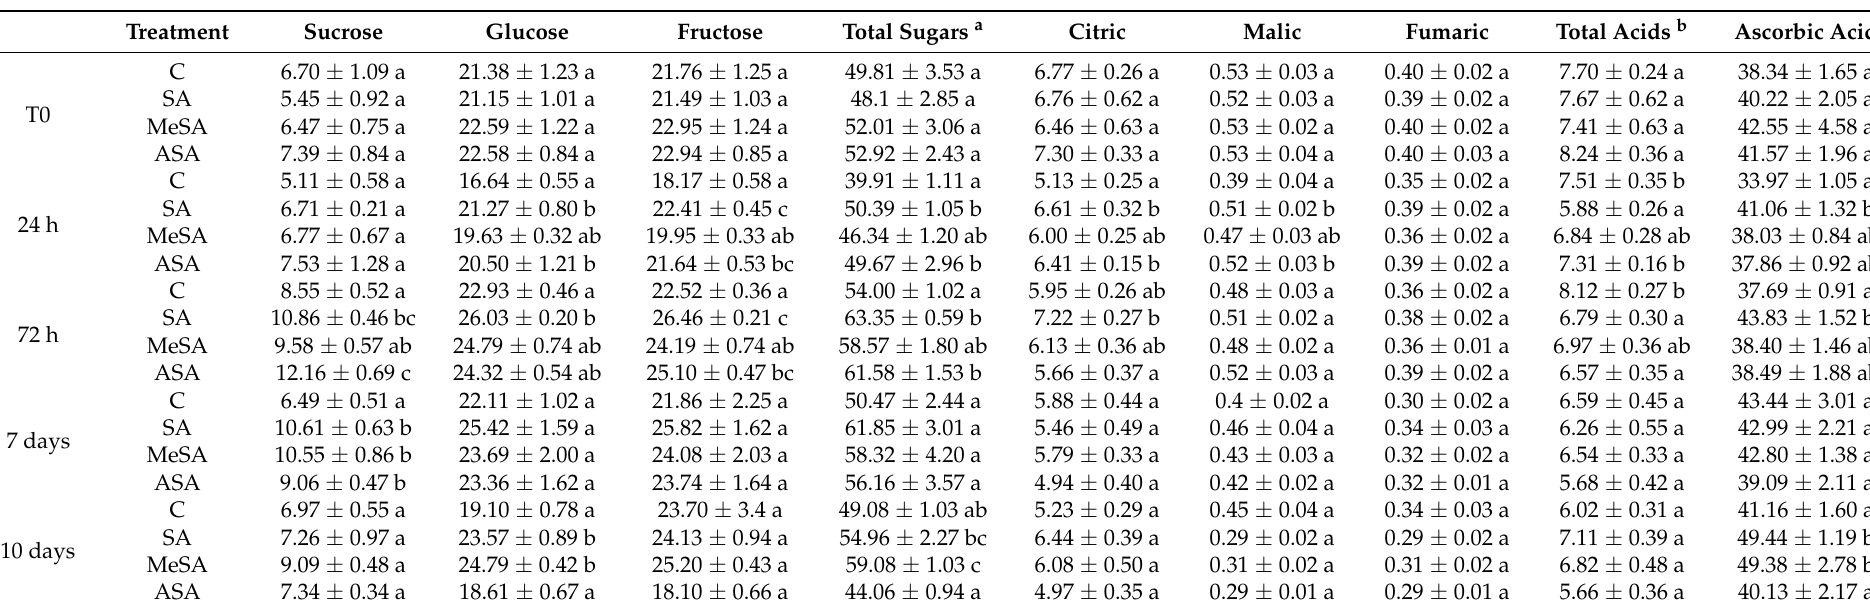
Table 2. Content of Sugars (g/kg FW), Organic Acids (g/kg FW) and Ascorbic Acid (mg/100 g FW) in Salicylic Acid (SA), Methyl Salicylic Acid (MeSA) and Acetyl Salicylic Acid (ASA) Treated Strawberries at Different Time Points (T0, 24 h, 72 h, 7 days and 10 days after treatments with